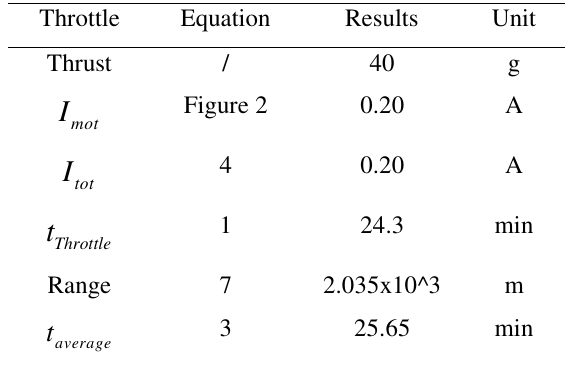
Table 2: Results for NAV in Throttle condition